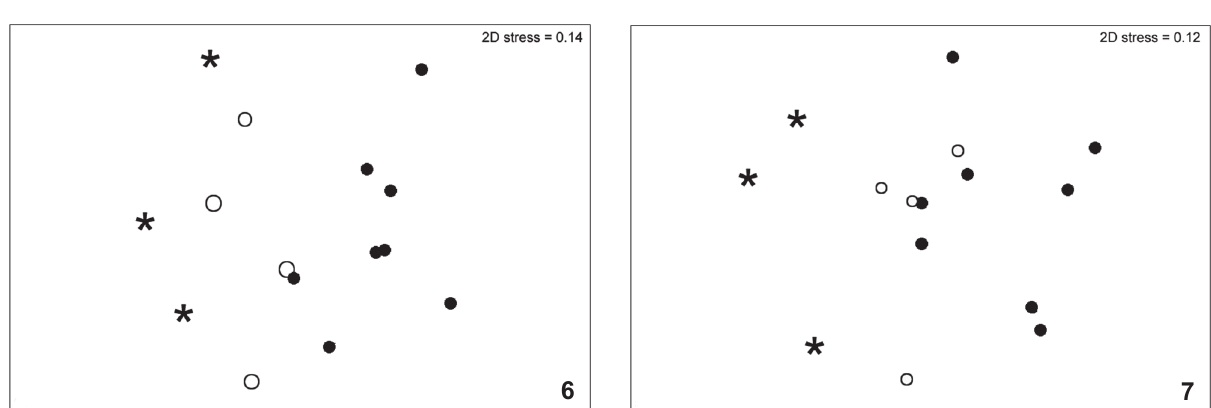
Figures 6-7. Ordination diagram representing two first axis of a Non-Metric Multidimensional Scaling Analysis of the six nektonic species and K. moenkhausii diet (6), and on the last species separately (7). Symbols represent sites according to riparian vegetation: absent (open circles), shrubs (star), and trees (dark